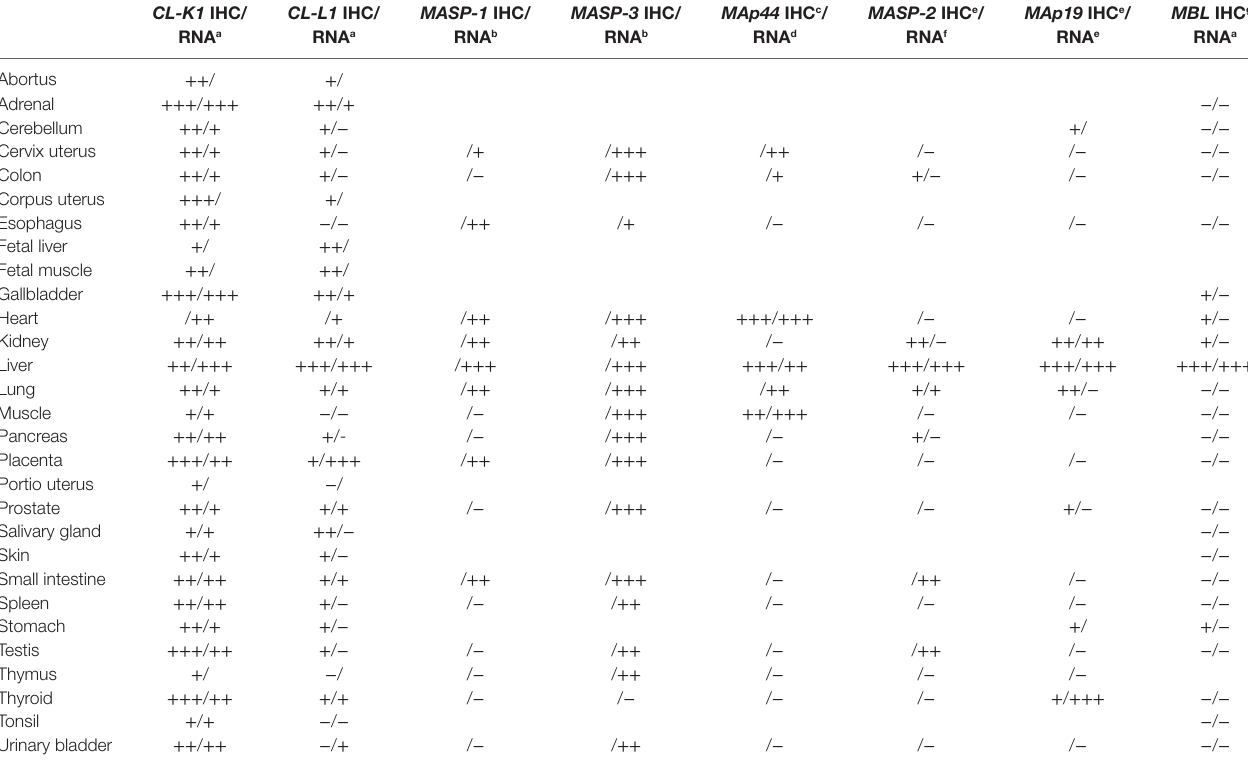
TaBle 1 | Levels of RNA expression: The symbols “ +++ ,” “ ++ ,” “ + ,” and “– ”denote high, medium, low, and absent/extremely low expression, respectively, based on the criteria established in Figures S1 and S2 in Supplementary Material. CL-K1 ihc/ rna